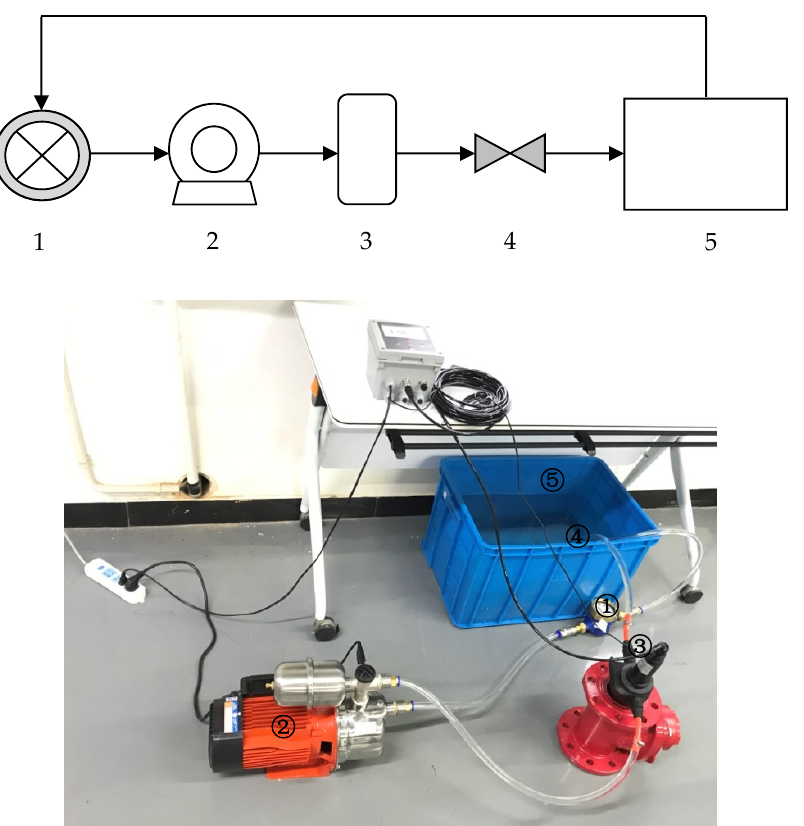
Figure 1. Schematic diagram and actual picture of the experimental setup. 1. Water meter; 2. Variable frequency pump; 3. Chemitec in-line turbidity meter (including temperature sensor); 4. Ball valve; 5. Water tank.